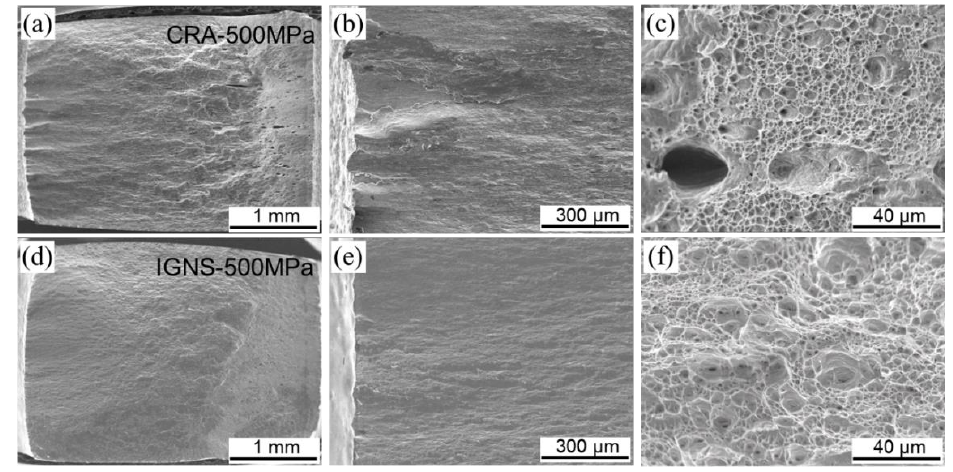
Figure 7. Fractography of ( a ) the CRA sample and ( d ) the IGNS sample under stress amplitude of 500 MPa. ( b , c ) and ( e , f ) show the crack initiation and final fracture area of the CRA and IGNS sample, respectively.